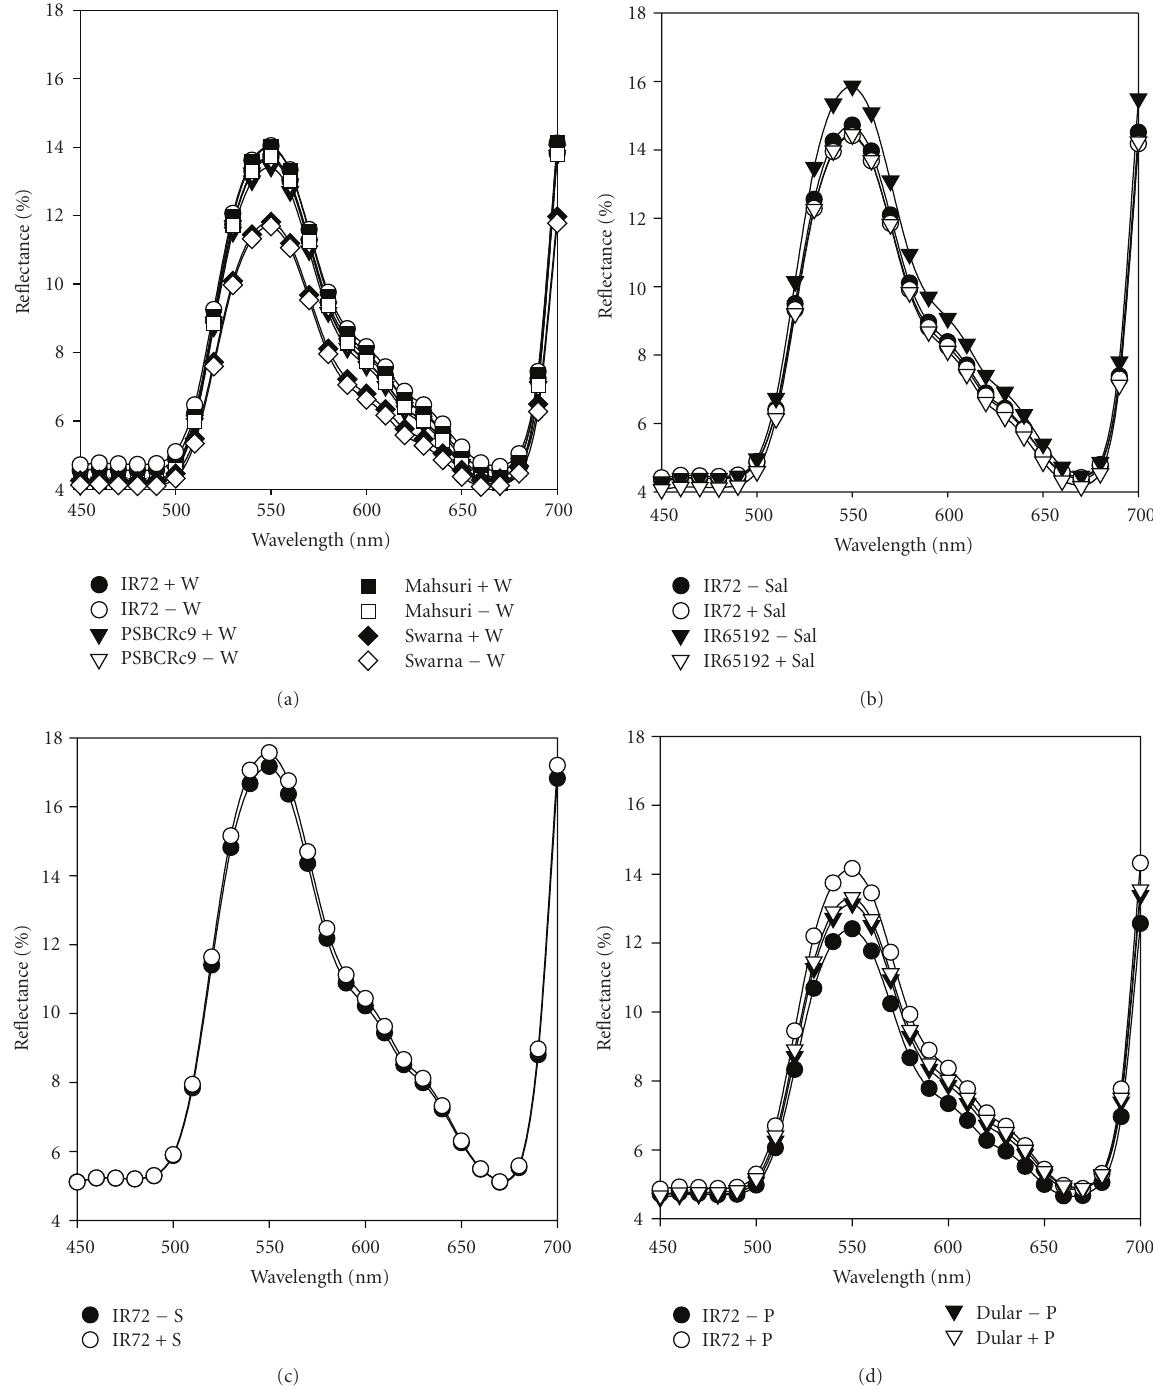
Figure 3: Leaf spectral reflectance scans for all stress and control treatments at 29 DAS (for salinity [ ± Sal], phosphorus [ ± P] deficiency, and sulfur [ ± S] deficiency) and at 47 DAS (at the end of the first drought phase for the water stress setup [ ± W]). Each curve represents the average of three